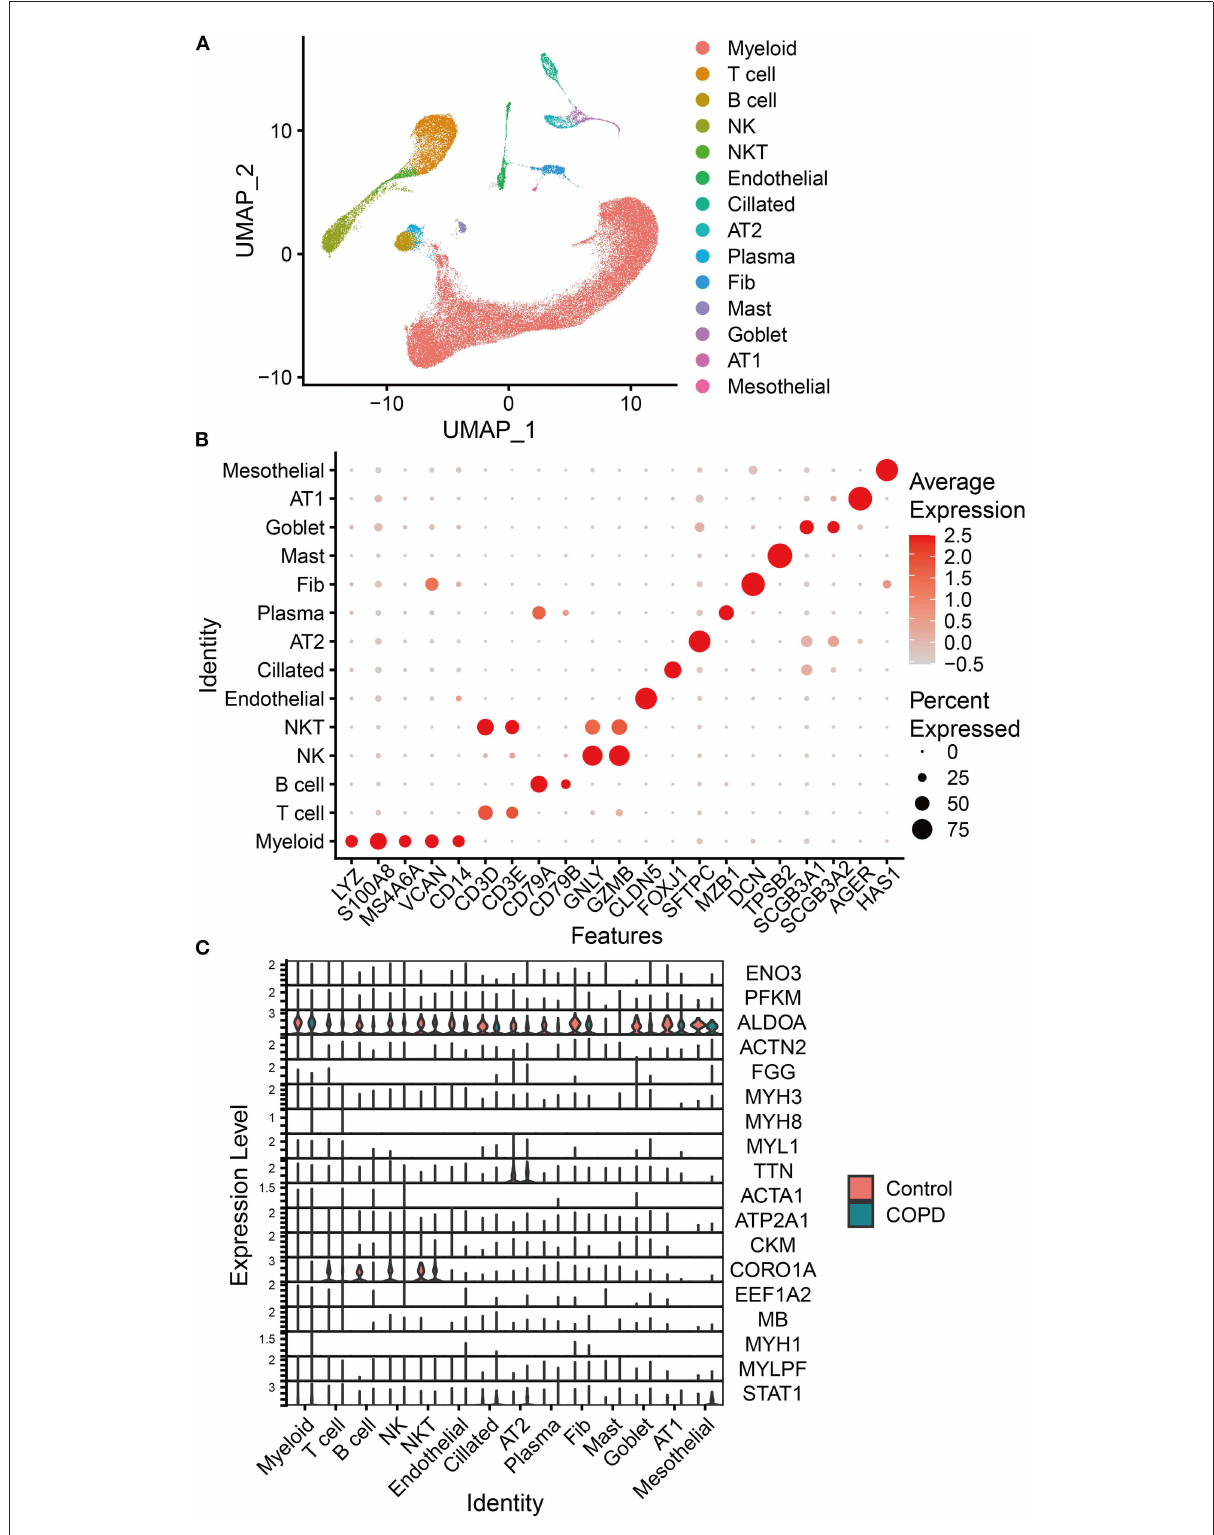
FIGURE6 Analysis of scRNA-seq analysis data. (A) Uniform manifold approximation and projection (UMAP) of the distribution of different cell subpopulations. (B) Expression of classical biomarkers related to 14 cell subpopulations. (C) Distribution and expression of the 19